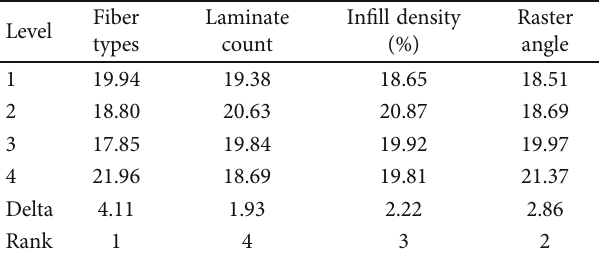
Table 3: Response table for means ( fl exural